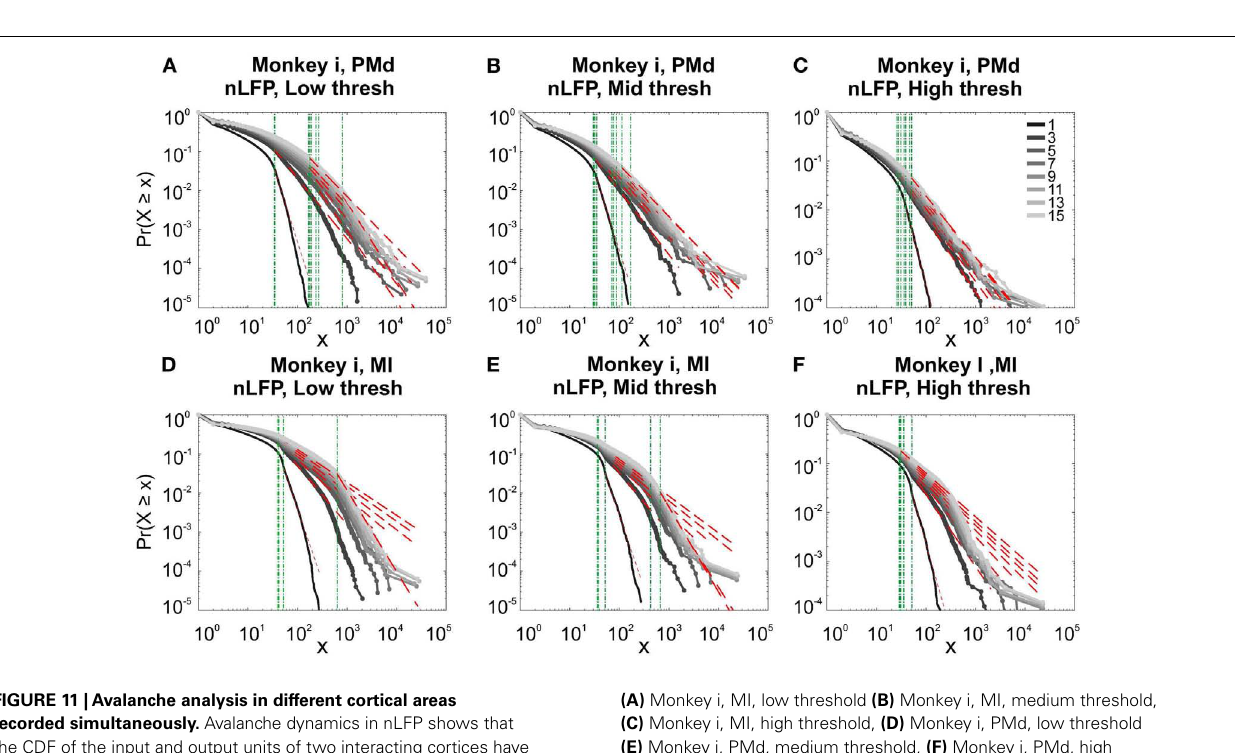
FIGURE 10 | Comparison ofAvalanche analysis based on negative and positive peaks. (A–C) Show the CDF for different thresholds of pLFP and (D–F) are related to nLFP. LFP (negative or positive) maxima avalanches for all coarse graining levels, as well as all thresholds did not show linear trend in